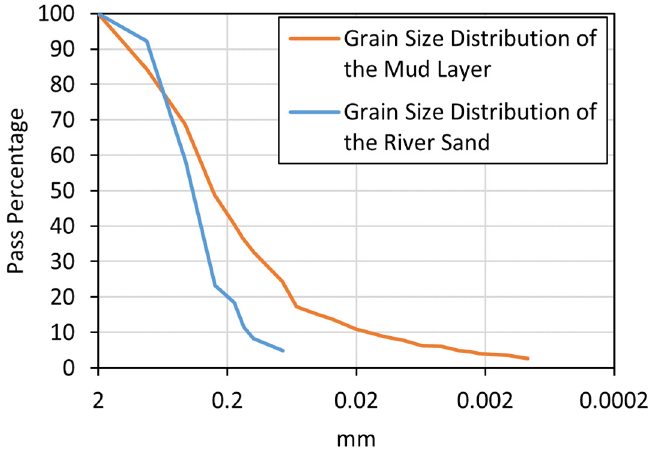
Figure 4. The particle size distributions of the river sand and the mud layer.